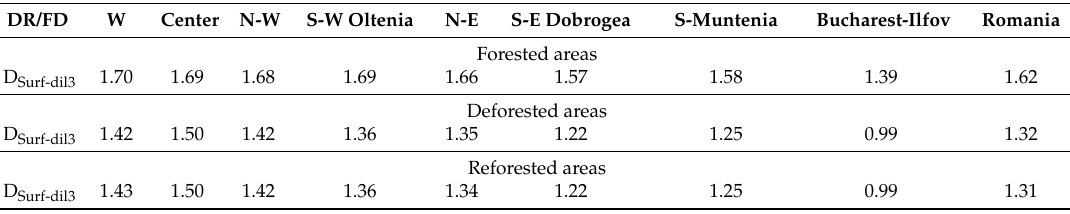
Table 5. The fractal dimension of forested, deforested and reforested areas (D Surf-dil3 ) from development regions of Romania